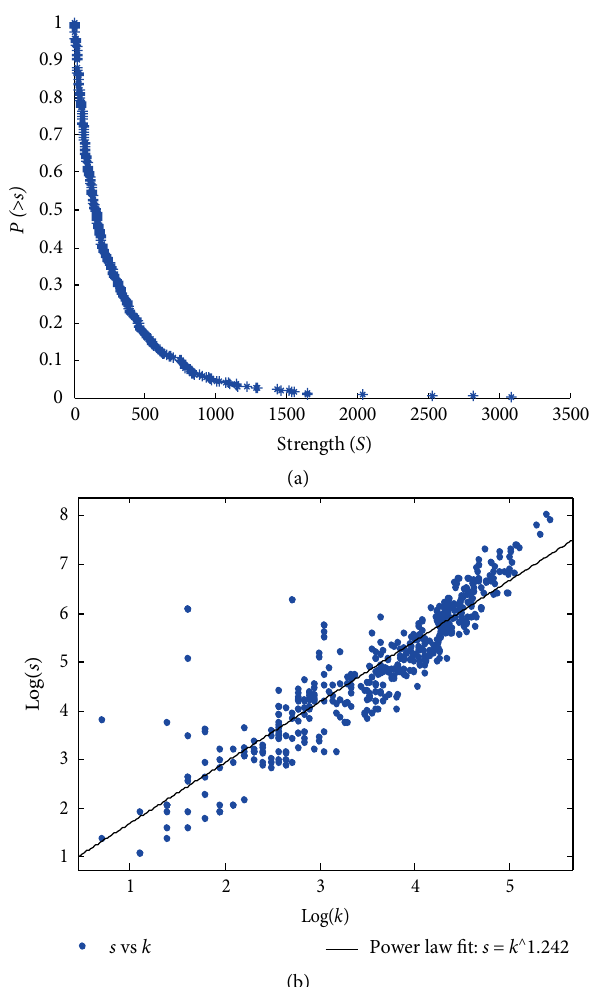
Figure 7: (a) Distribution of SC and (b) DC versus SC.